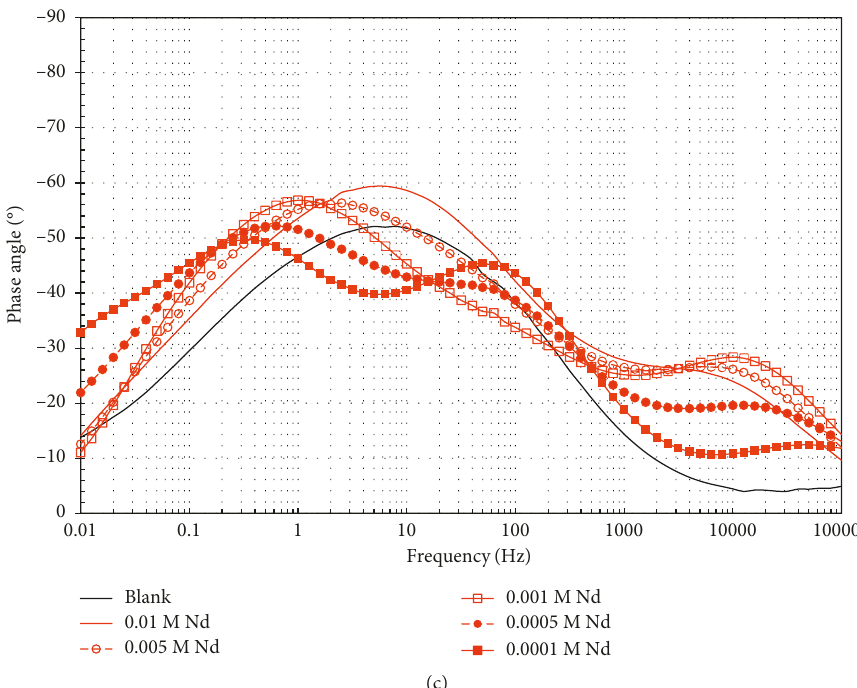
Figure 6: Nyquist and Bode diagrams for API X70 steel with and without the addition of Nd 3+ ions after 100 hours of immersion in 3.5% NaCl